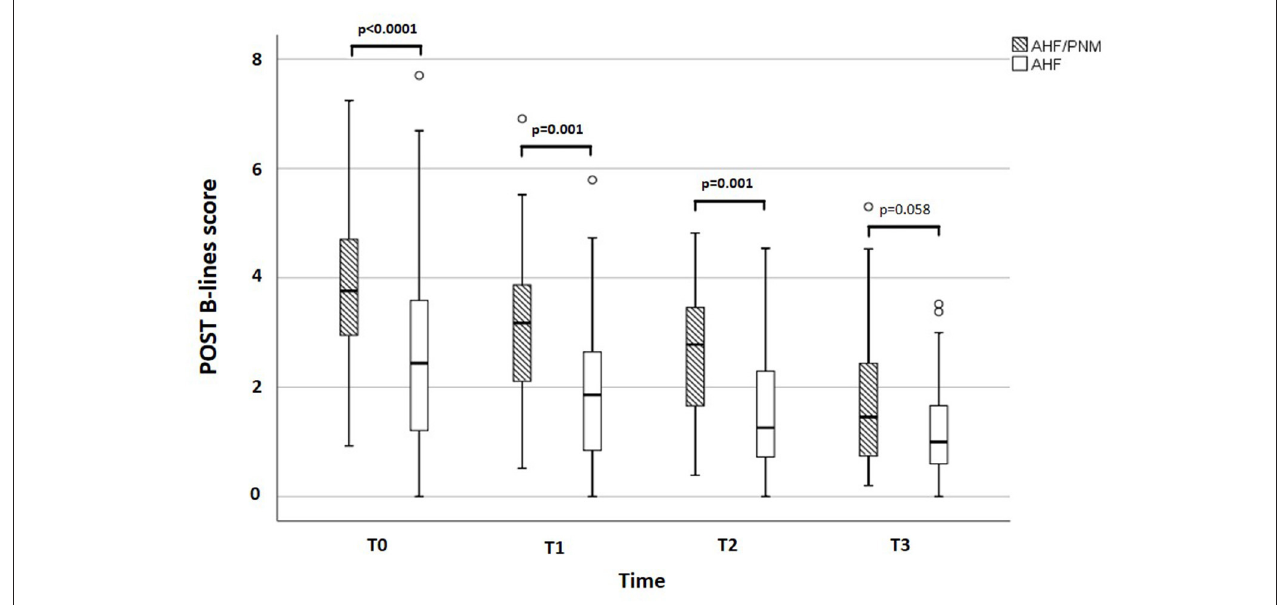
FIGURE 2 | Difference in POST B-lines score at each time point between AHF/PNM and AHF patients. Box and whisker graph describing the difference in POST B-lines score between AHF/PNM and AHF patients. POST, posterior; AHF: isolated acute heart failure; AHF/PNM, acute heart failure with concomitant pneumonia; PNM, pneumonia.